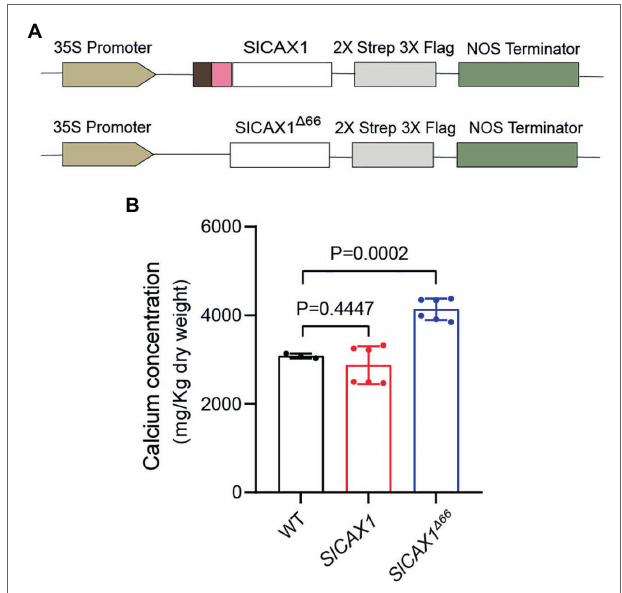
FIGURE 6 | Overexpressing SlCAX1 Δ 66 in tomato increased the calcium content. (A) Schematics of vectors used to express different truncated versions of SlCAX1 in tomato. (B) Calcium content of different lines. A Student’s t -test was used to analyze the data. Error bars represent standard error of the mean of six biological